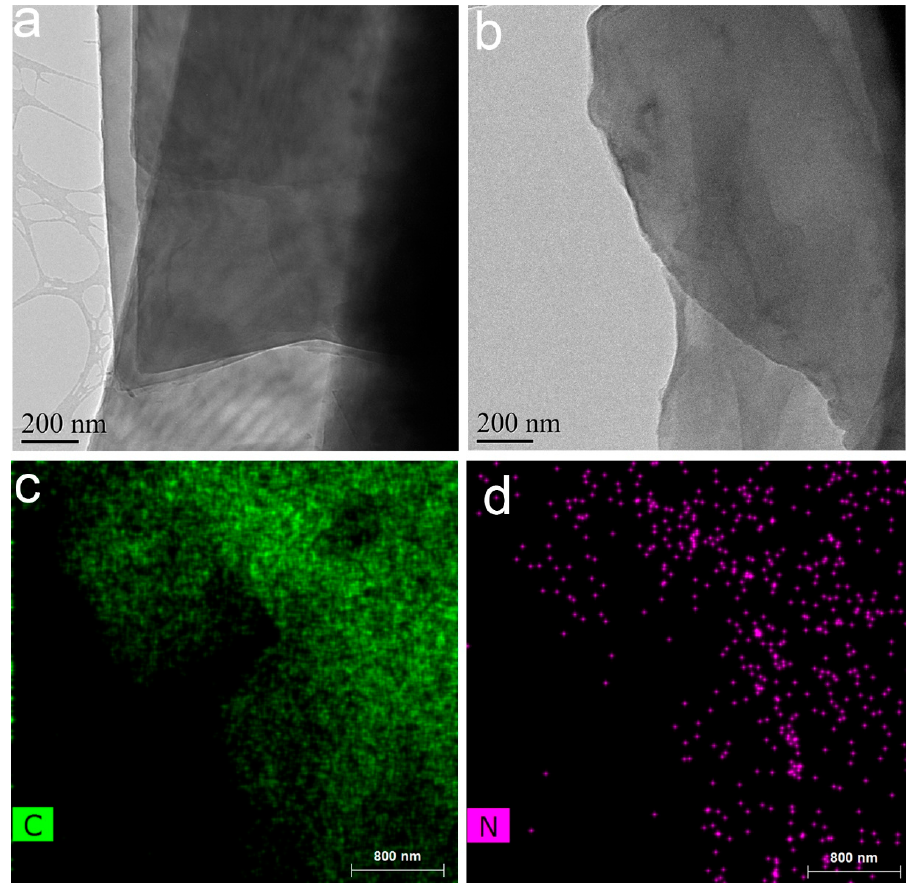
Figure 2. The TEM images of GO ( a ) and PDA-RGO ( b ), and elemental mapping of PDA-RGO ( c and d ).